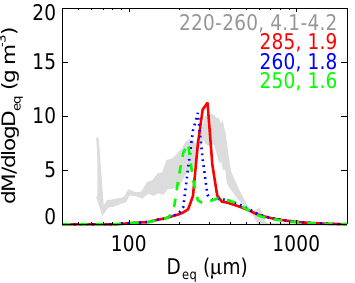
Figure 18. Fluffy ice size distributions at − 40 ◦ C for simulations as in Fig. 16 but with fluffy ice treated as plates. Details provided in